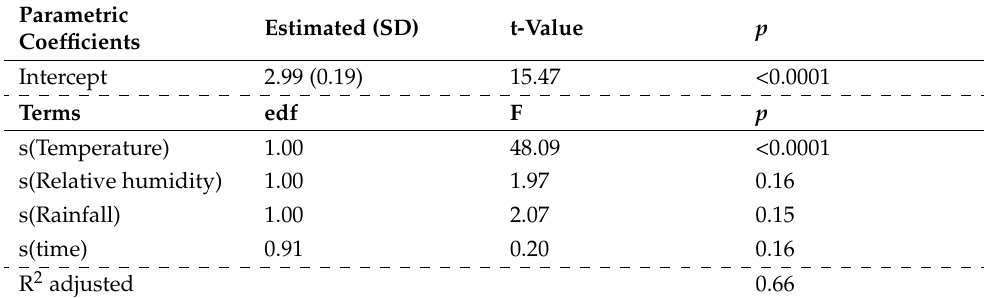
Table 1. Summary of the generalized additive mixed models (family quasi-Poisson, link = log) for the number of LCSB moths collected and the variables of air temperature, relative humidity, and rainfall from the previous 45 days (average) before the data collection in Jay, Santa Rosa County, Florida. edf = effective degrees of freedom ( n = 85).